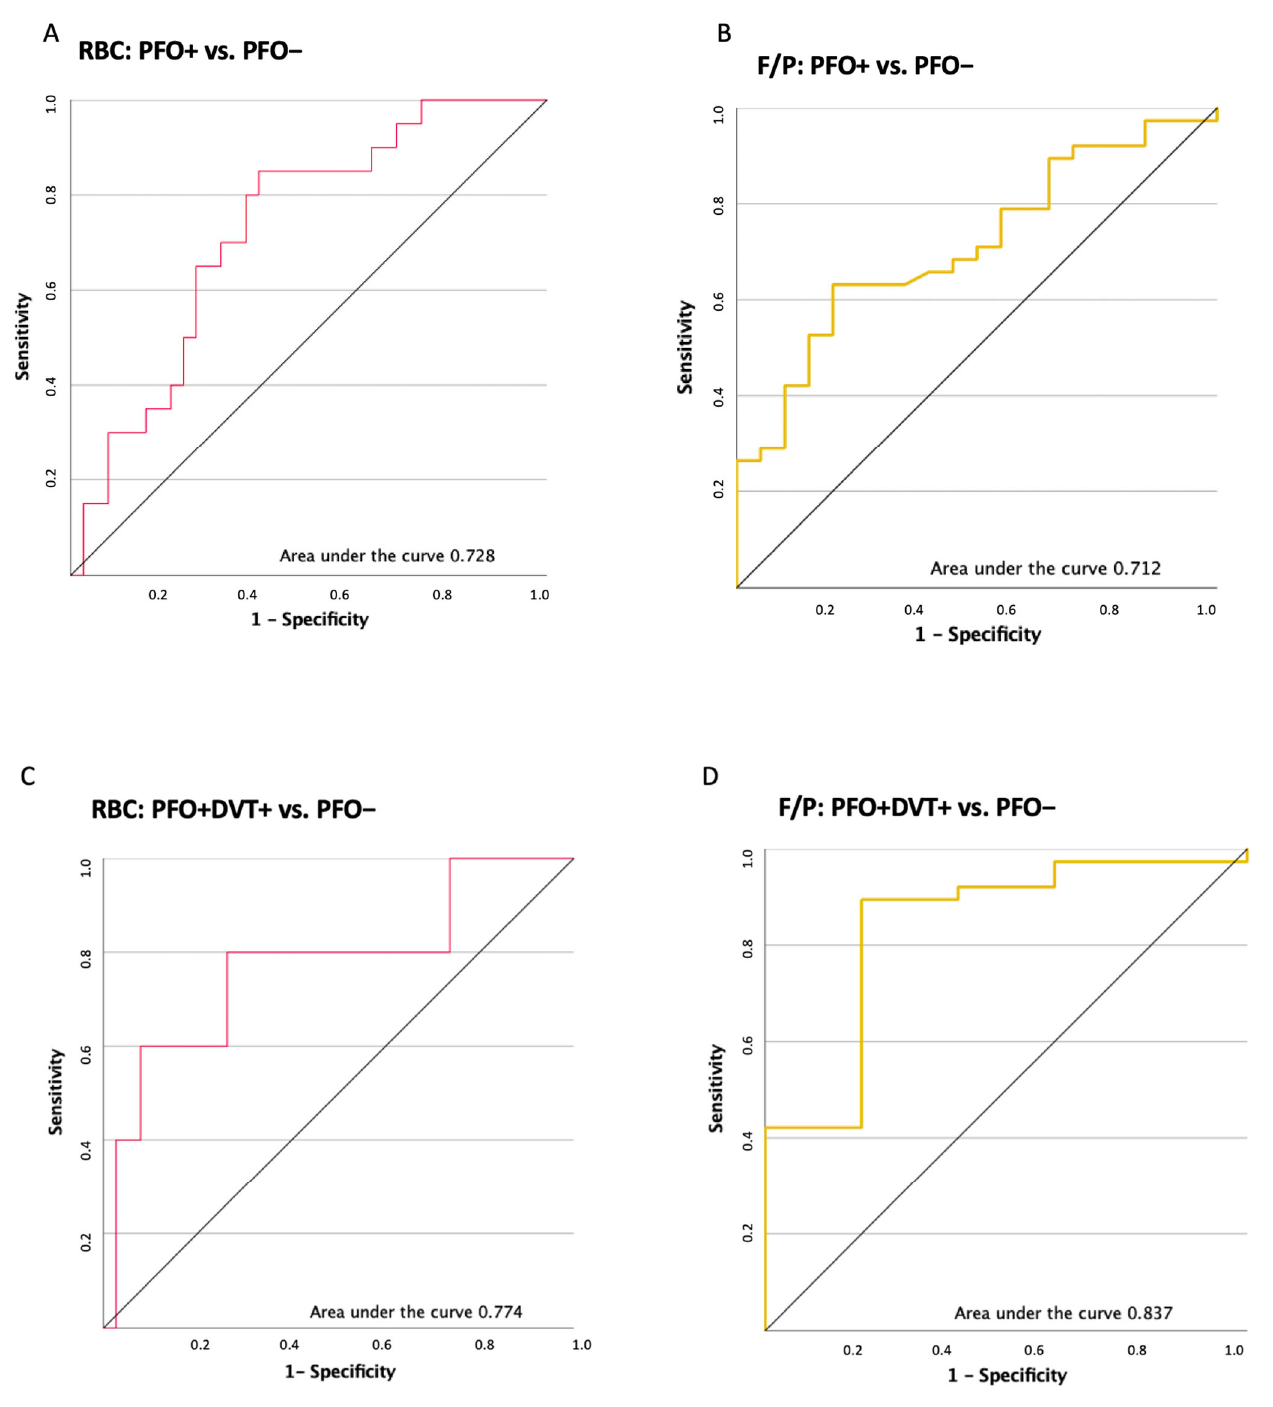
Figure 3. ROC analysis for red blood cell (RBC) and fibrin/platelet (F/P) share comparing PFO+ as well as PFO+DVT+ patients to PFO– patients. ROC analysis ( A ) for RBC in the PFO+ and PFO– subgroup. The area under the curve was calculated at 0.728 ( B ) for F/P share in the PFO+ and PFO– subgroup. The area under the curve was calculated at 0.712 ( C ) for RBC share in the PFO+DVT+ and PFO– subgroup. The area under the curve as calculated at 0.774 ( D ) for F/P share in the PFO+DVT+ and PFO– subgroup. The area under the curve was calculated at 0.837. RBC depicted in ( A , C ) in red lines. F/P share depicted in ( B , D ) in yellow lines.